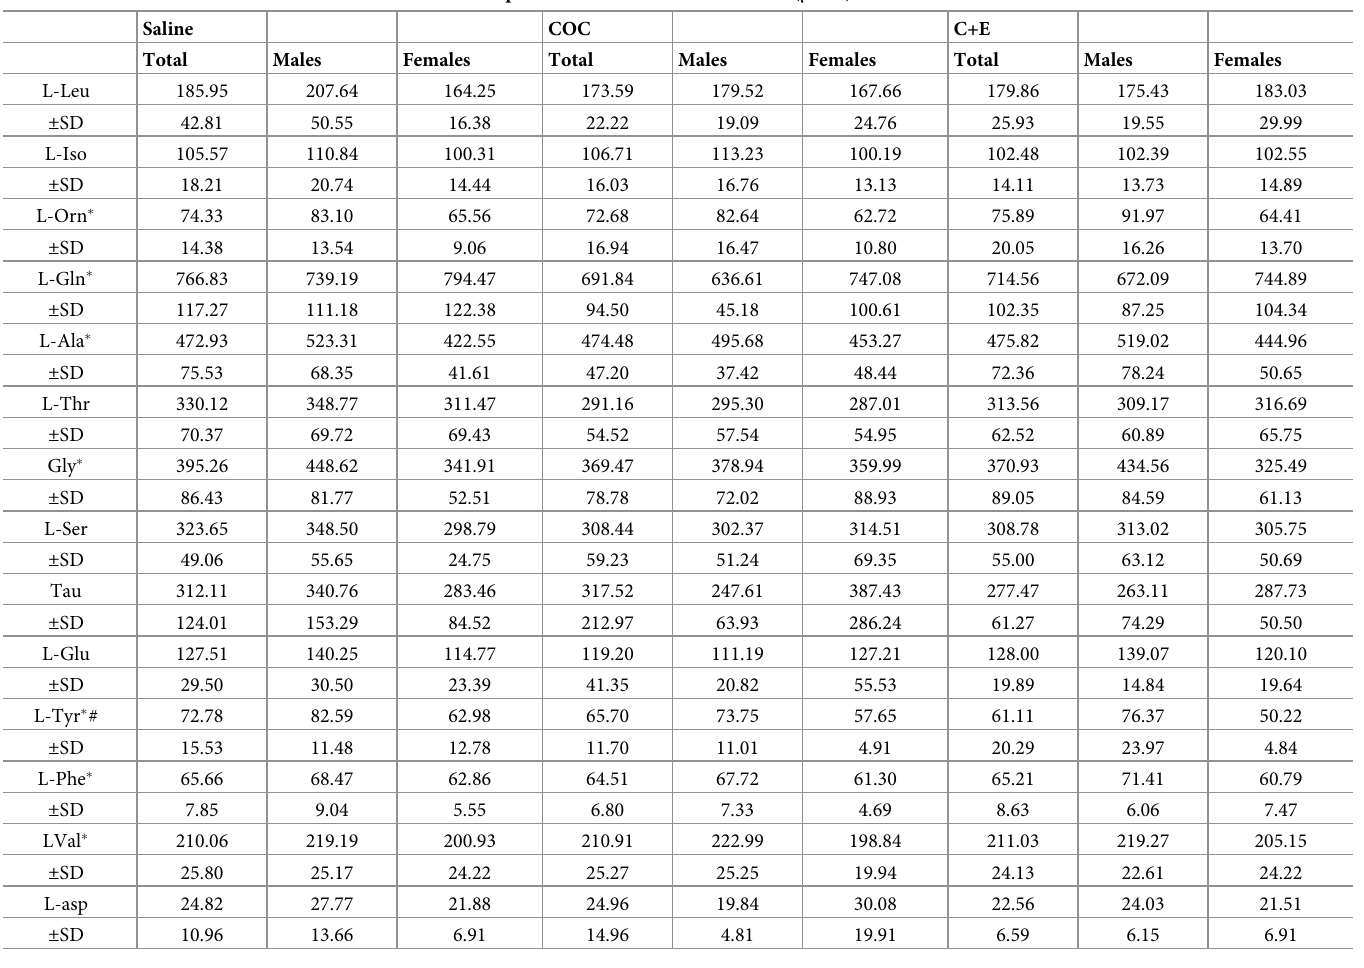
Table 1. Effect of self-administration of cocaine and C+E on plasma amino acid concentrations ( μ